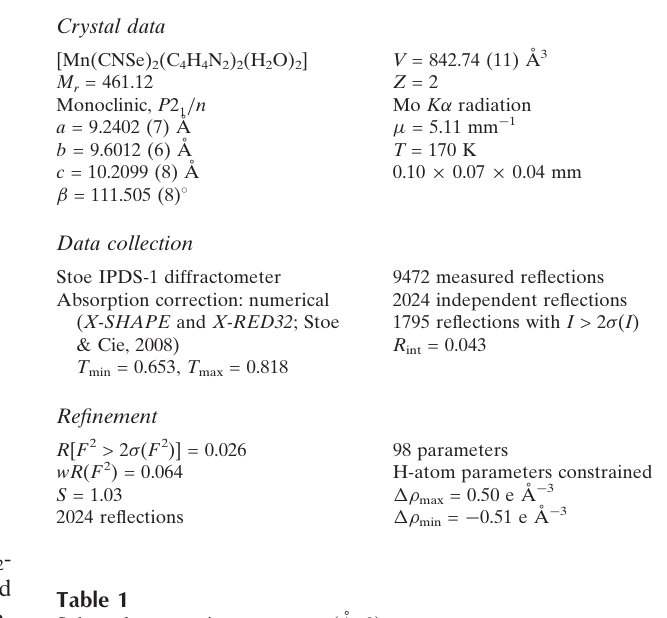
Selected geometric parameters (A˚ , (cid:3) ).